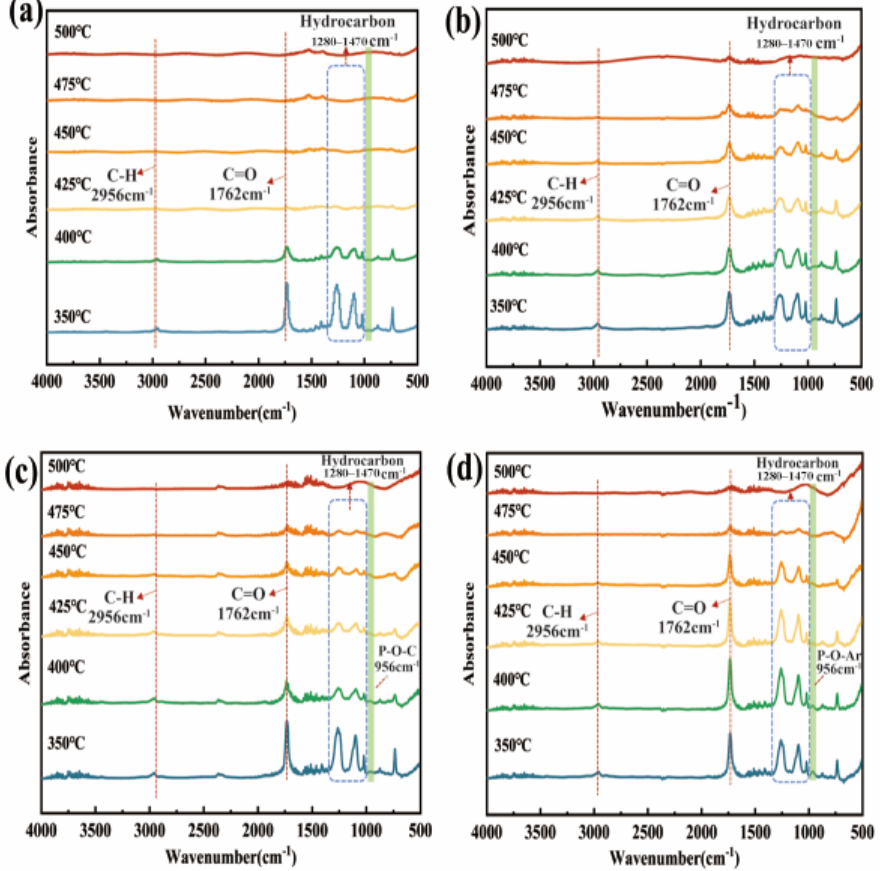
Figure 5. FTIR spectra of PET ( a ), PBPP/PET ( b ), PBPDP/PET ( c ) and PBDP/PET ( d ) at different temperatures.